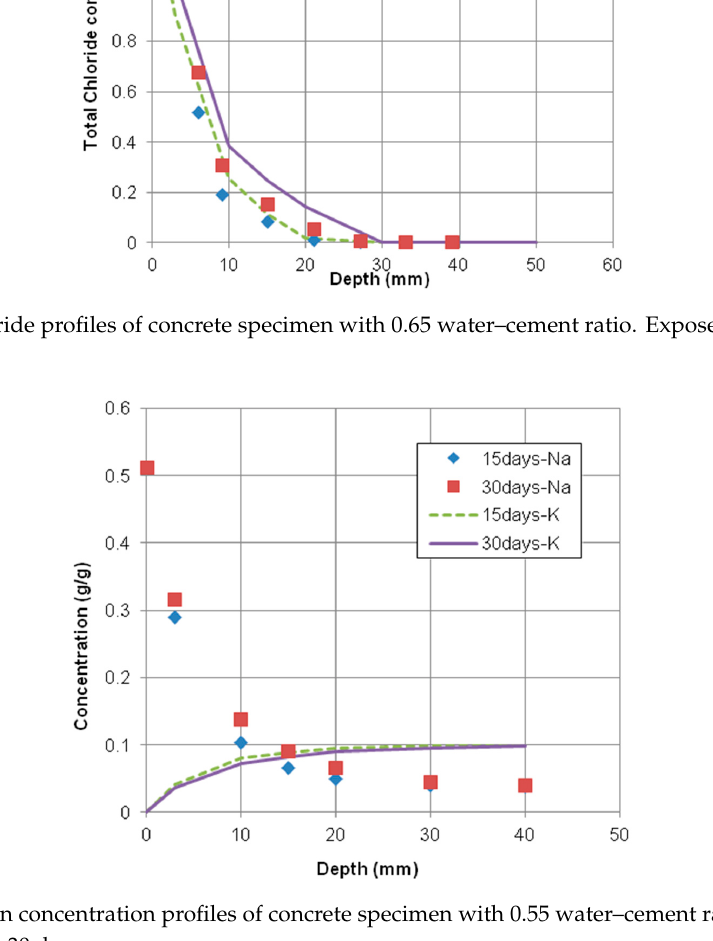
Figure 6. Comparison of test and numerical results. The specimen was exposed for 15 days and 30 days [48]. 4.2. Prediction for Multispecies Transport in Nonsaturated Concrete 4.2.1. Numerical Example This study focused on the chloride penetrating into concrete specimen from the top surface. The dimension of the specimen was 15 cm high and 30 cm wide as shown in Figure 7a. The top surface of concrete specimen was exposed to the solution of 3% of NaCl and 3% of CaCl 2 , and the other species, Na + , K + , and OH − , were initialized to be dissolved in the concrete pore solution. Particularly, the concentration of alkali ions in pore solution, Na+ and K + , was obtained from cement manufacturer which provided the chemical composition of cement [48]. In reality, not only single type of deicing salt is used but also different combinations of deicing salts are frequently used at the same location. Therefore, in this example, the combination of 3% of NaCl and 3% of CaCl 2 was used as the boundary condition. All other sides except the top surface were assumed to be sealed. The moisture condition inside the concrete specimen was assumed to be partially saturated with 60% relative humidity (RH).